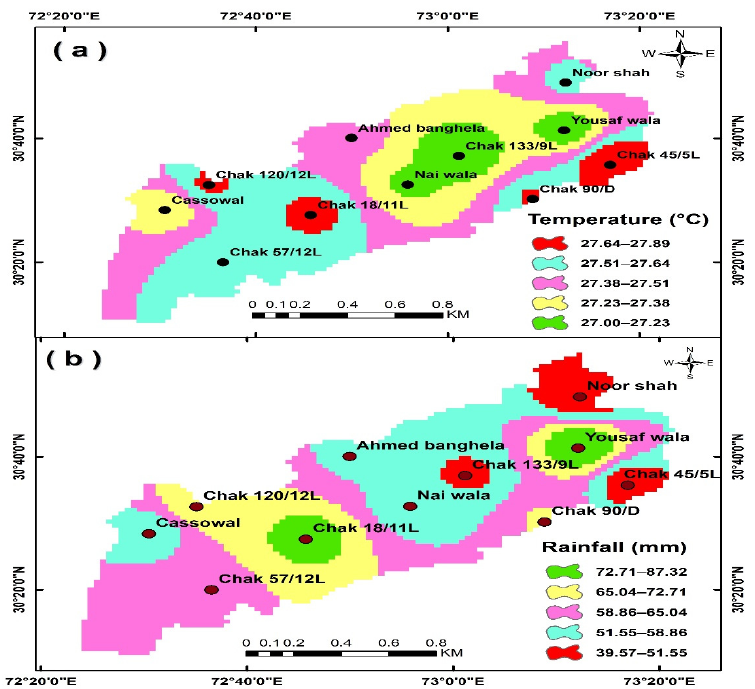
Figure 7. Average temperature and rainfall maps of the Sahiwal district from 1981 to 2021 by survey Figure 7. ( a )Average temperature and ( b ) rainfall maps of the Sahiwal district from 1981 to 2021 by points. survey